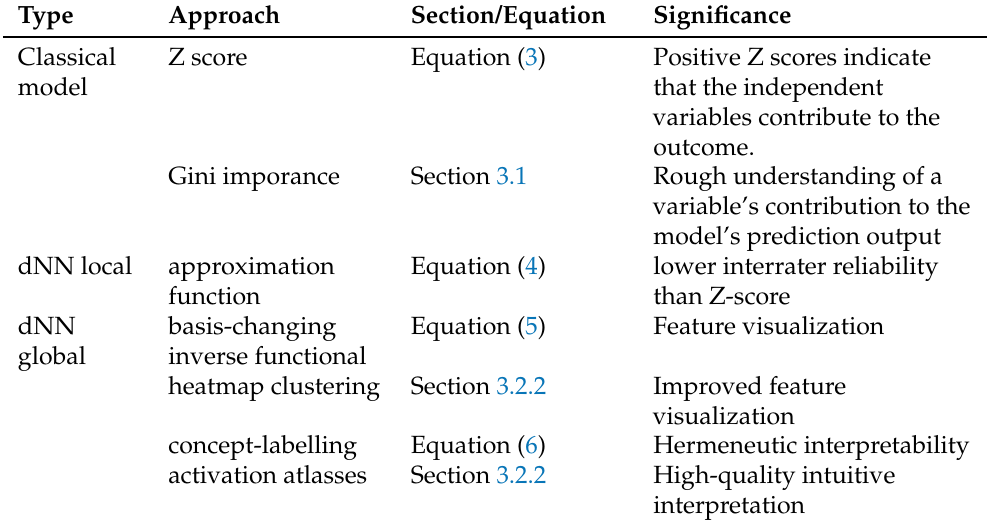
Table 1. Overview: Types of interpretations of